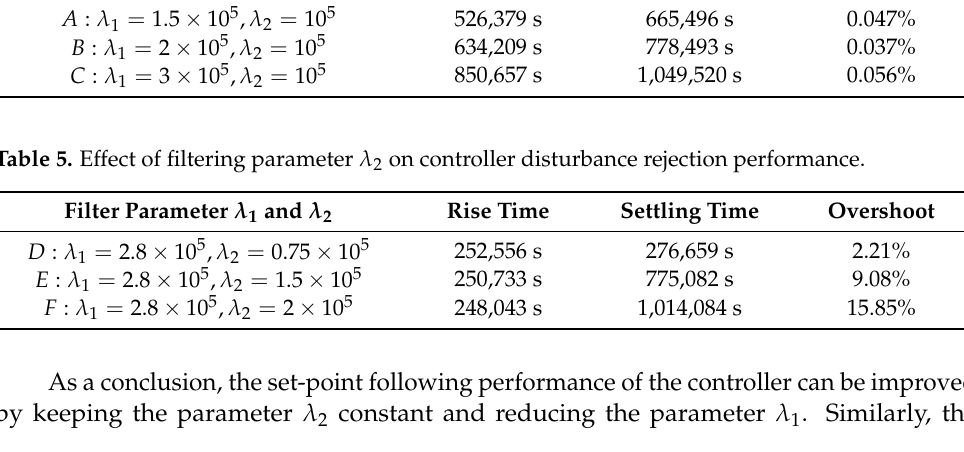
λ on controller set-point tracking performance.